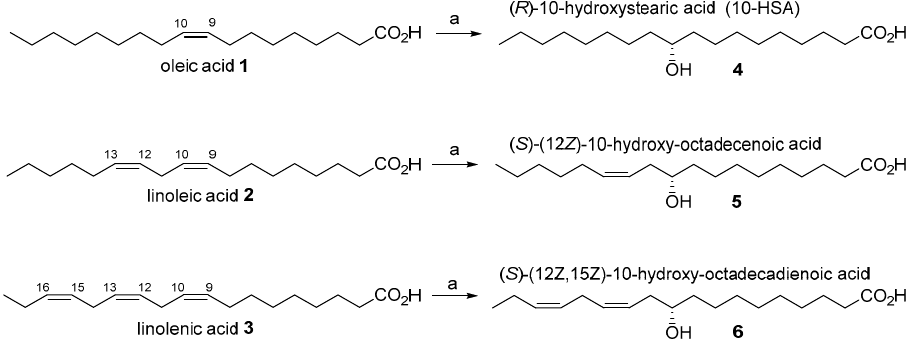
Figure 1. The most common C 18 unsaturated fatty acids: oleic ( 1 ), linoleic ( 2 ) and linolenic ( 3 ) acid and their transformation into ( R )-10-hydroxystearic acid ( 4 ), ( S )-(12 Z )-10-hydroxy-octadecenoic acid ( 5 ) and ( S )-(12 Z ,15 Z )-10-hydroxy-octadecadienoic acid ( 6 ), respectively. Reagents and conditions: (a) anaerobic fermentation with Lactobacillus rhamnosus ATCC 53103.